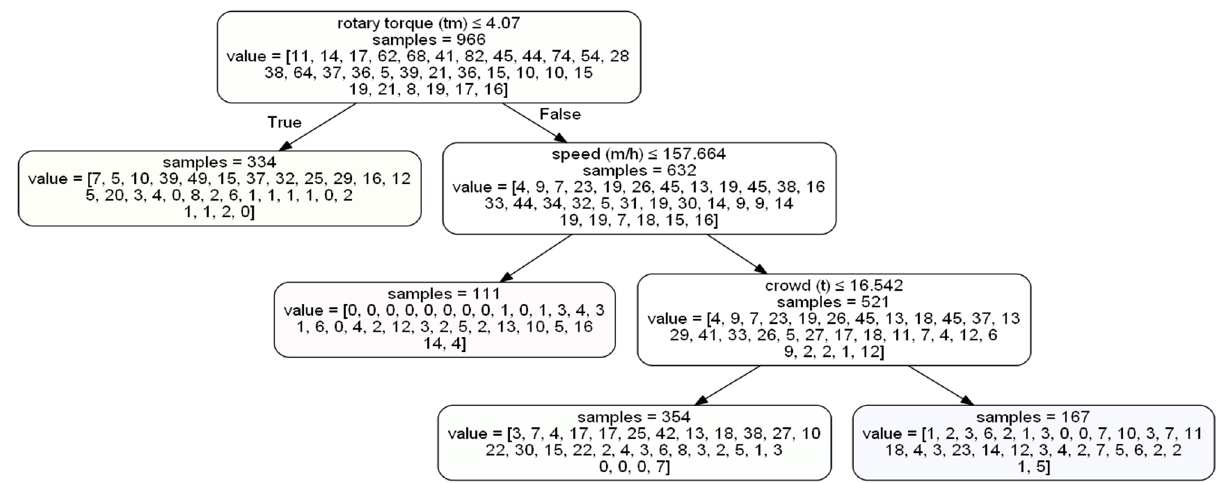
Figure 2. Decision tree example for site 1, limited to 4 leaf nodes.